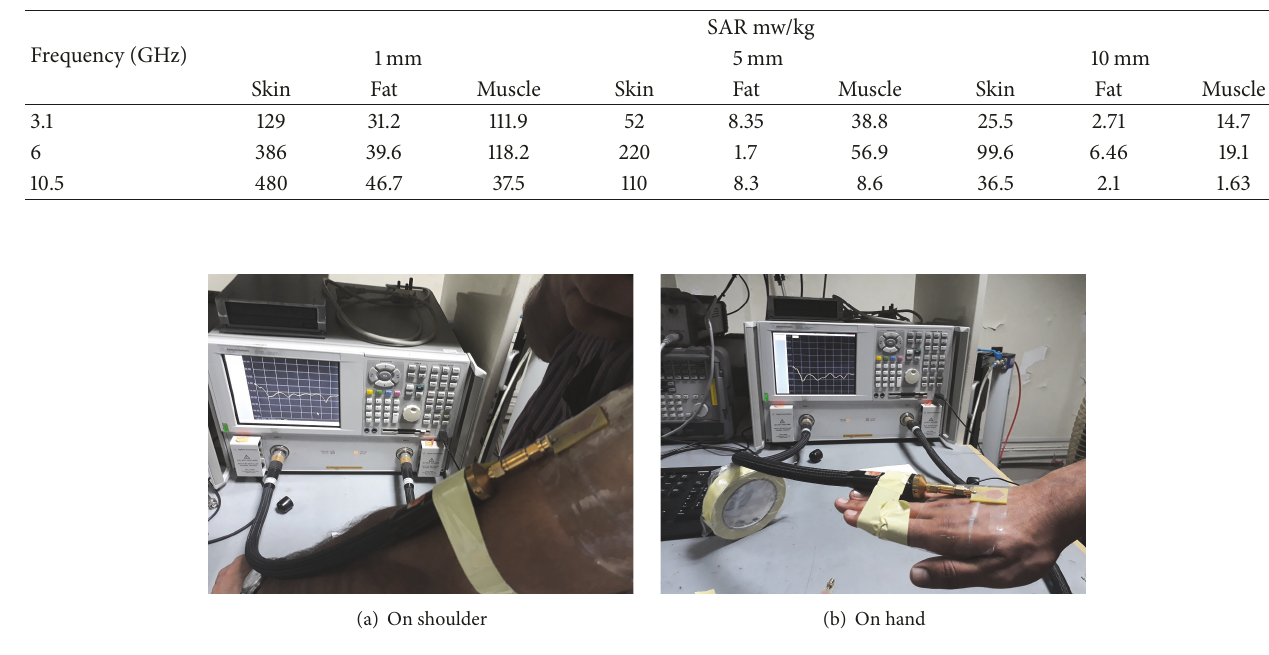
Table 2: 1 gram averaged peak SAR values with different antenna distances from the phantom.